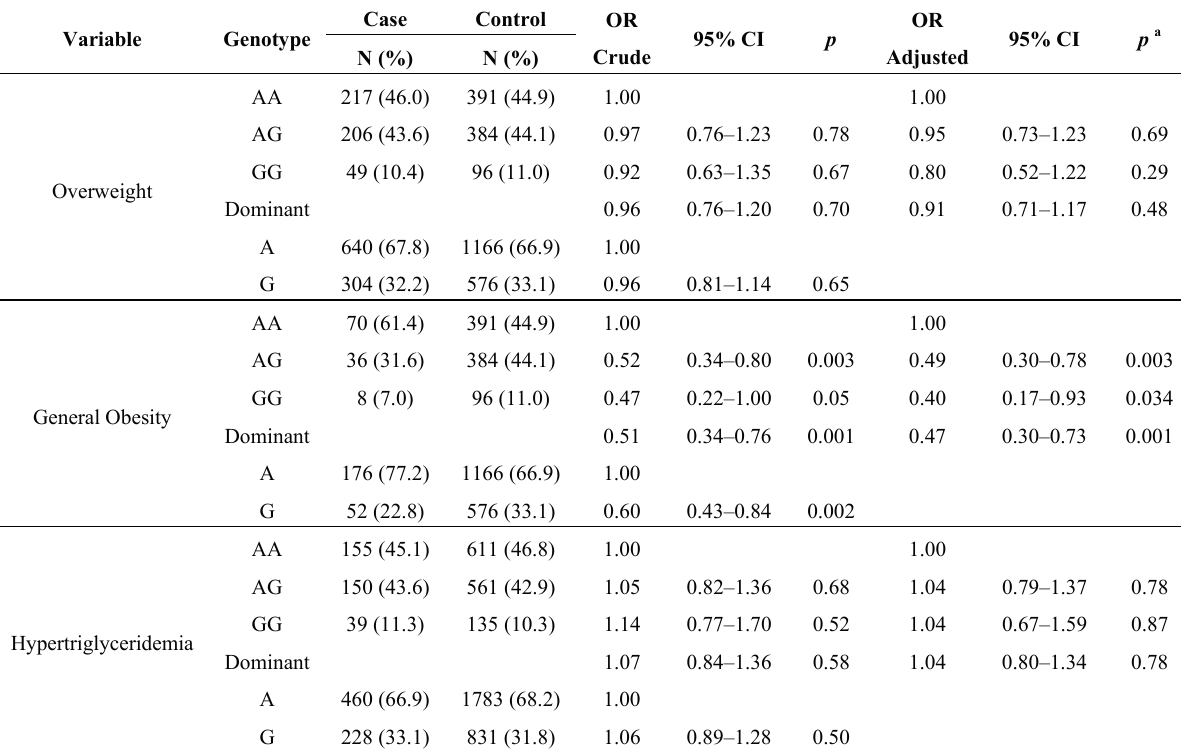
Table 3. Genotype frequencies of STAT3 polymorphism rs1053005 and its association with the risks of metabolic